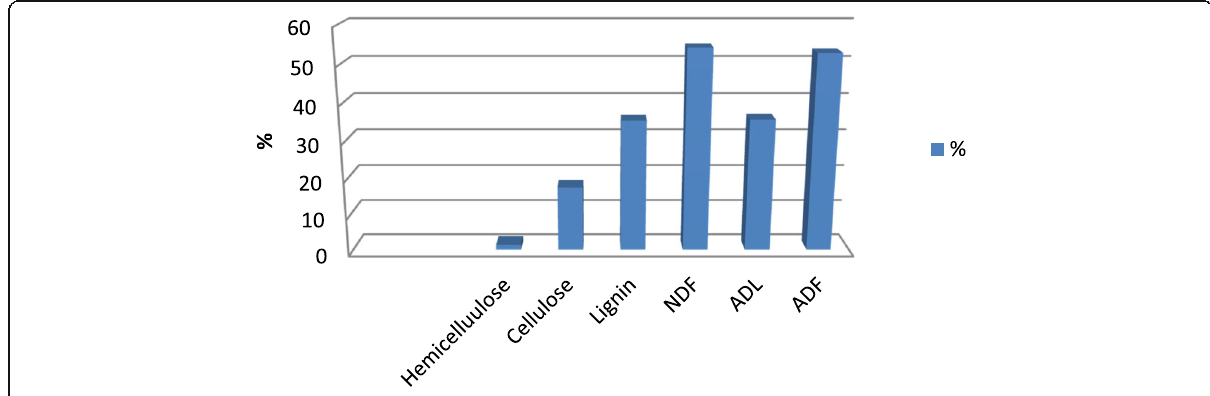
Fig. 1 Dietary fiber composition of jojoba hull. ADF acid detergent fiber, ADL acid detergent lignin, NDF neutral detergent fiber